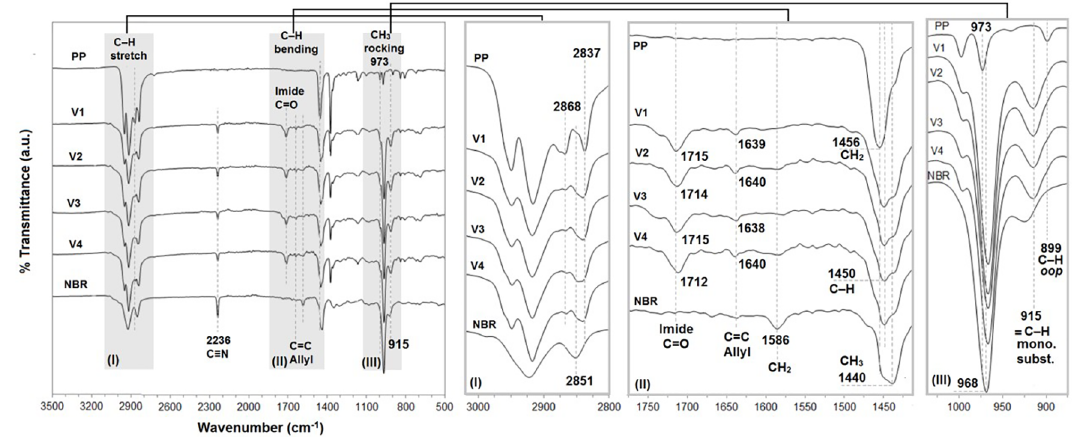
Figure 3. Typical ATR-FTIR spectra of neat PP, neat NBR and PP/NBR (30/70) TPV mixers by different rotor speed profile: C-H stretch regions (I and III) and Carbonyl region (II). V1= 60/60/60 rpm; V2=60/40/40 rpm; V3=60/40/60 rpm; V4=60/80/60 rpm.